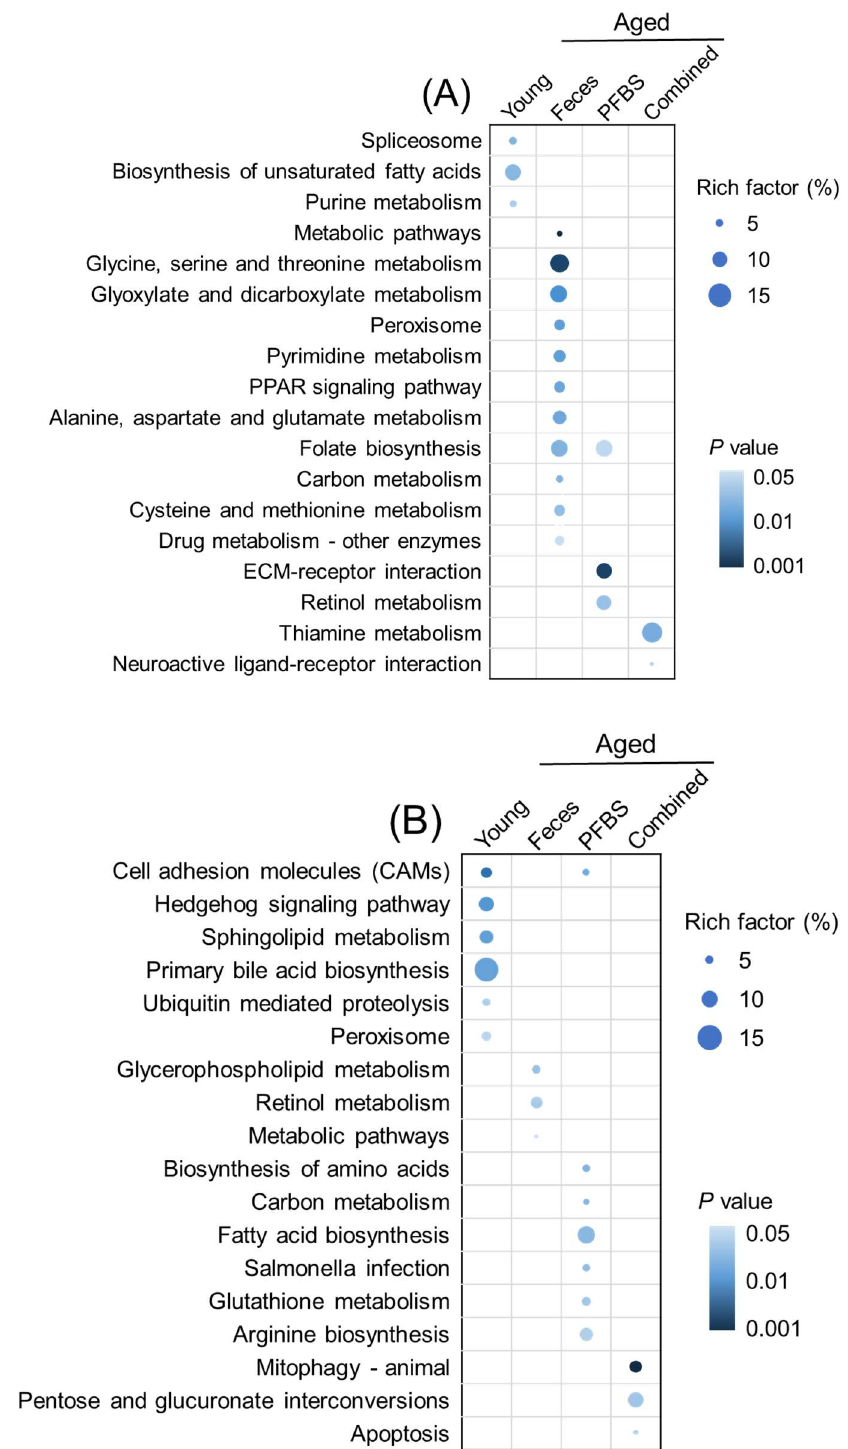
Figure 6. KEGG pathways of significant enrichment in male ( A ) and female ( B ) zebrafish gonads after exposure to PFBS (0 and 100 µg/L) with or without the transplantation of young donor feces. Color intensity is proportional to the enrichment significance ( p value). The circular area represents the rich factor.